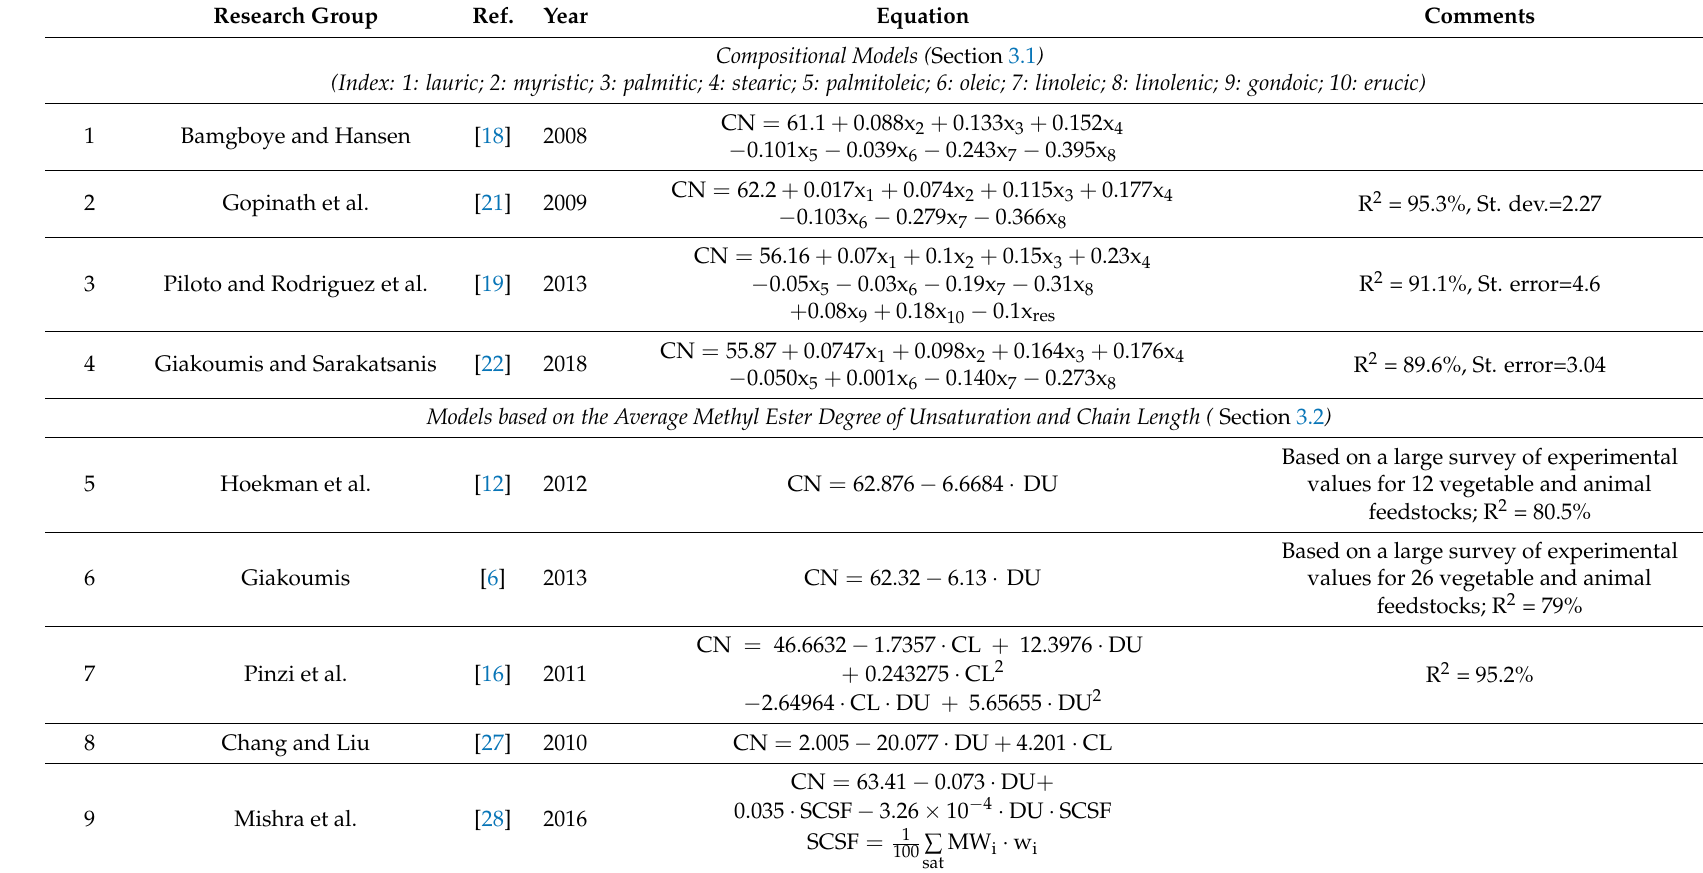
Table 3. Summary of methyl esters CN predictive correlations based on the FA composition (R 2 and standard error values refer to the degree of correlation of the developed equation with the data its derivation was based on, as provided in the original